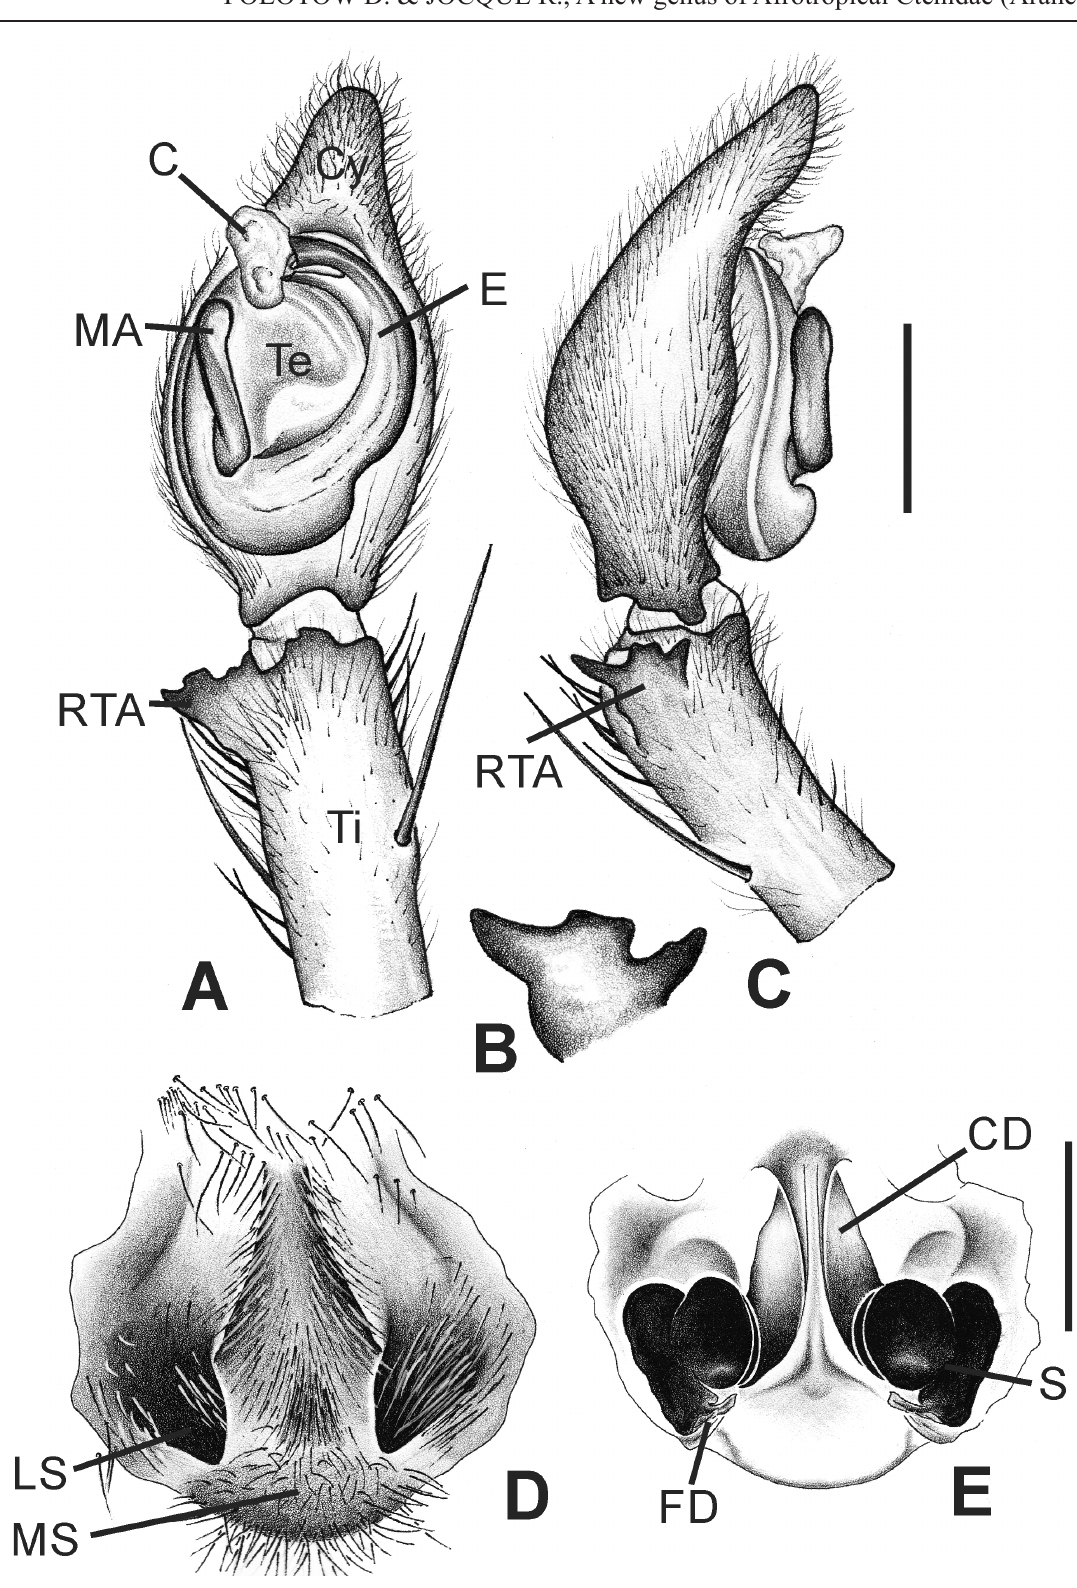
Fig. 3. Afroneutria velox (Blackwall, 1865) comb. nov. — A–C . Male palp. A . Ventral view. B . Retro- lateral view. C . Retrolateral tibial apophysis, lateral view. — D–E . Female genitalia. D . Epigynum, ventral view. E . Vulva, dorsal view. Scale bars = 1